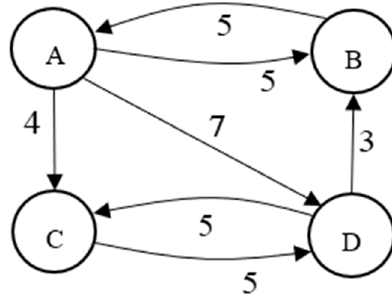
Figure 3. Weighted semidirected graph.